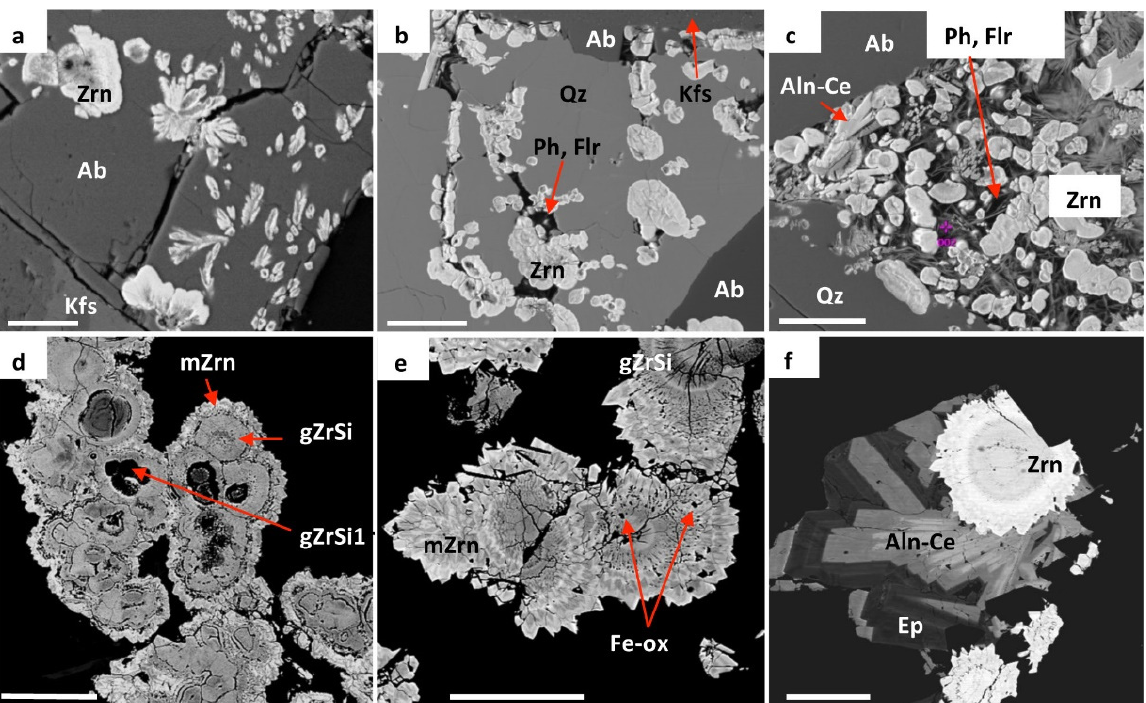
Figure 2. BSE images of hydrothermal zircon aggregates in peralkaline granite from the Corupá Pluton. ( a ): Dendritic, rosette, oolitic, and other zircon (Zrn) aggregates included in and probably co-precipitated with hydrothermal albite (Ab); note the zoning patterns with grayish or darker core areas and whitish rims. ( b ): Botryoidal and oolitic hydrothermal zircon, accompanied by minor phyllosilicates (Ph) and fluorite (Flr), filling in fractures in primary quartz (Qz) and protruding a K-feldspar (Kfs) substrate, along with hydrothermal albite. ( c ): Zoned zircon aggregates with a variety of morphologies, associated with phyllosilicates, fluorite, and allanite-(Ce) (Aln-Ce), filling in a small miarolitic cavity; note the shell-shaped crypto-crystalline aggregate with a concentric zoning pattern in the center of the image. ( d ): Botryoidal zircon aggregates, with subrounded globules mainly composed of Zr and Si (gZrSi) packed together and enveloped by microcrystalline zircon overgrowths (mZrn); note the dark cores in some globules (gZrSi1) and dark spots in-between globules and overgrowths. ( e ): Botryoidal aggregate with better-developed microcrystalline aggregates over globular nuclei; note the concentric zoning pattern and Fe-oxide (Fe-ox) “inclusions” and other unidentified dark spots accompanying this pattern. ( f ): Spherulitic, crypto-to-microcrystalline, fibro-radiated zircon aggregate with concentric zoning pattern, associated with allanite-(Ce) and brighter ferriallanite-(Ce) and epidote (Ep) fibro-radiated aggregate, filling in a miarolitic cavity. White bars measure 10 µ m ( a – c ) and 50 µ m ( d – f ). Mineral abbreviations as recommended by the IMA [46]. See text for